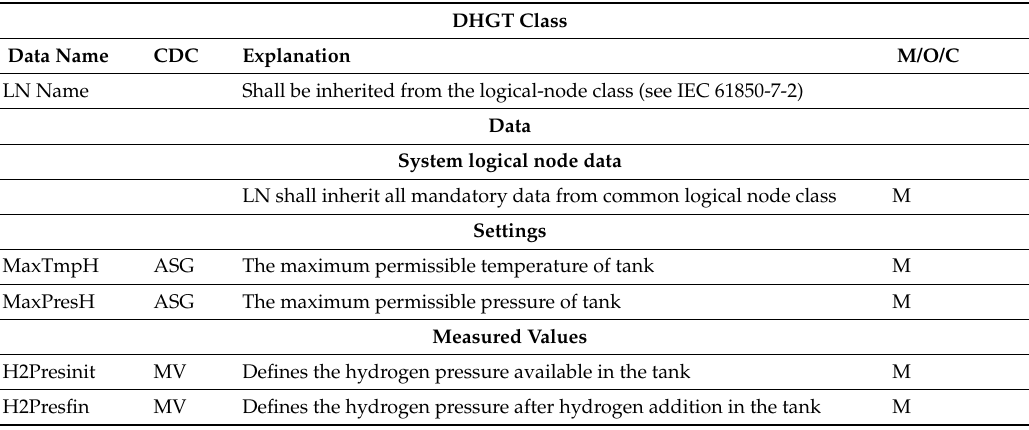
Table 7. Hydrogen tank (DHGT) logical